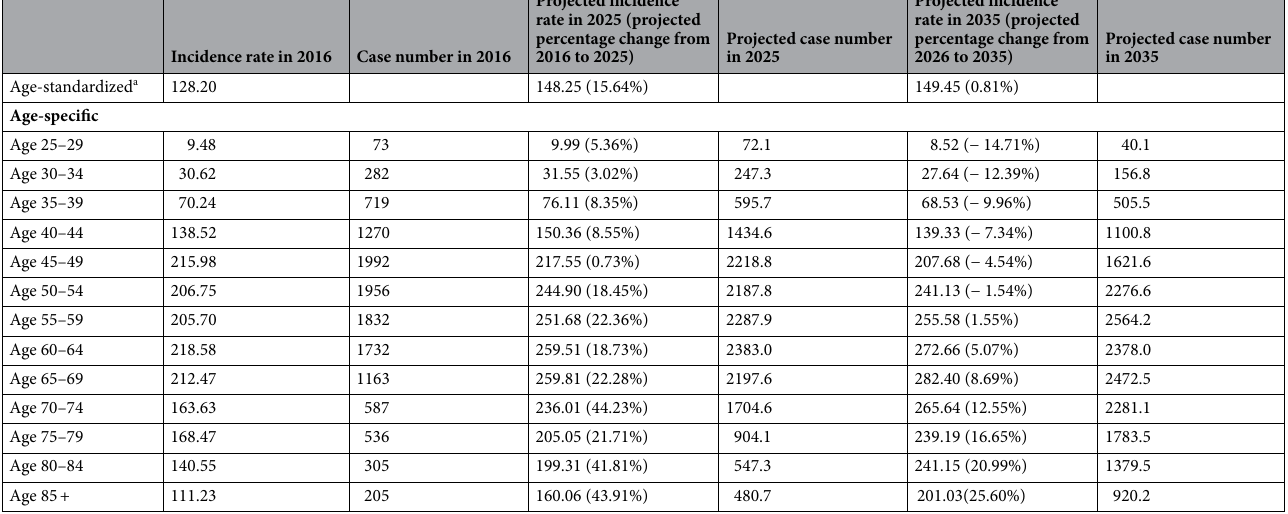
Table 1. Age-standardized and age-specific breast cancer incidence rates per 100,000 population (the observed rates in 2016 and the projected rates in 2025 and 2035) and the projected percentage changes from 2016 to 2025 and 2026 to 2035. a The World Health Organization’s 2000 world standard populations were used to compute the truncated age-standardized incidence rate (age range 25 +